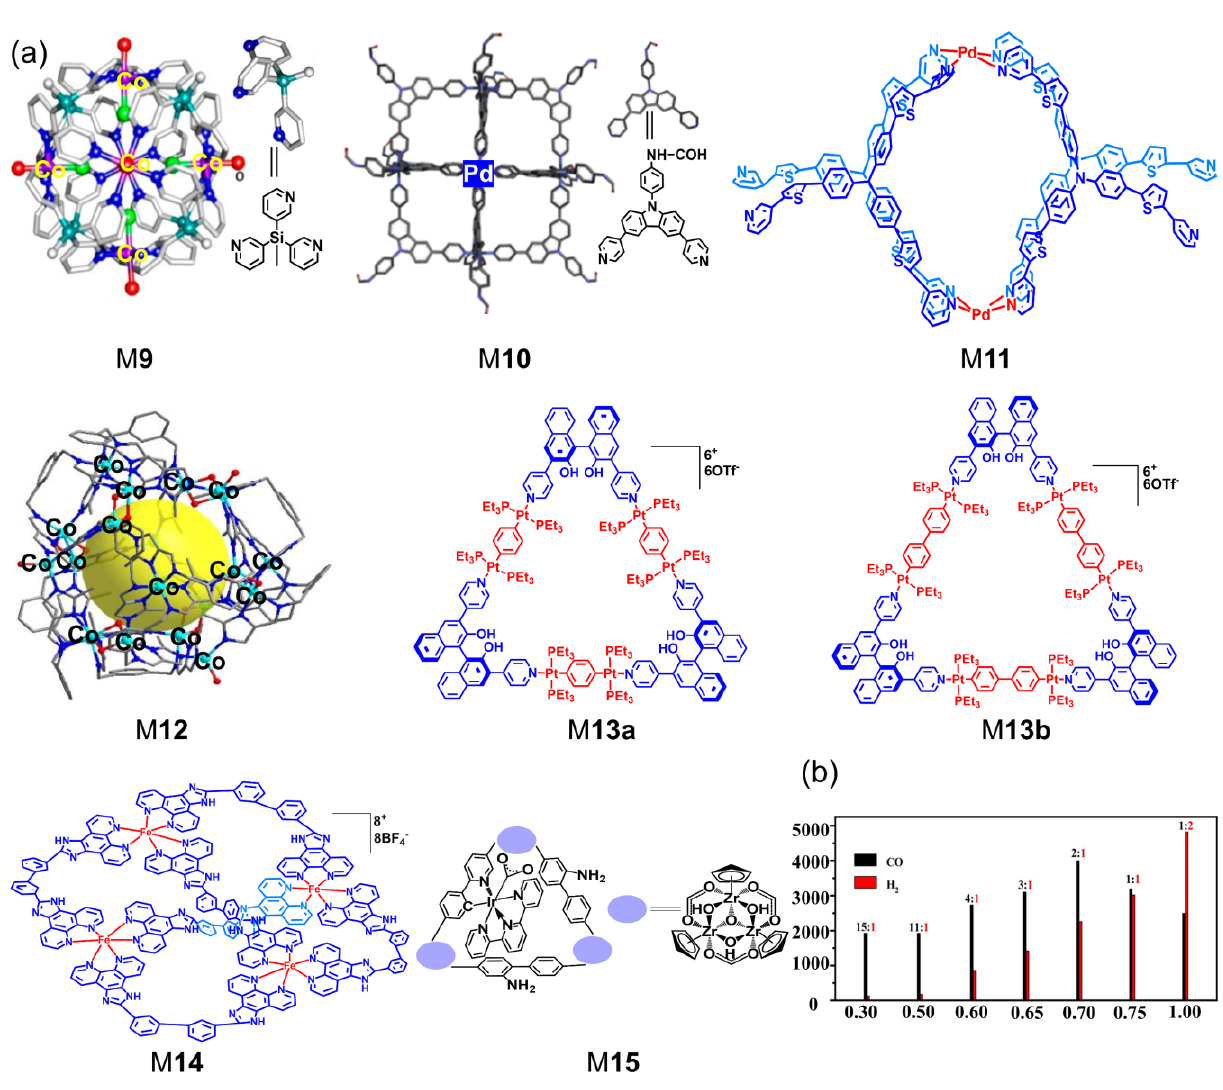
Figure 2. Catalysis of metallacycles and metallacages. ( a ) The structures of M 9 − M 15 . ( b ) Histogram of CO/H 2 generation by ReP/TiO 2 -M 11 in CO 2 -saturated DMF solutions with different water contents for 5 h under visible light. Adapted with permission from refs. [9,30,50,51,58–60]. Copyright 2017, 2020, 2021, and 2022 American Chemical Society.